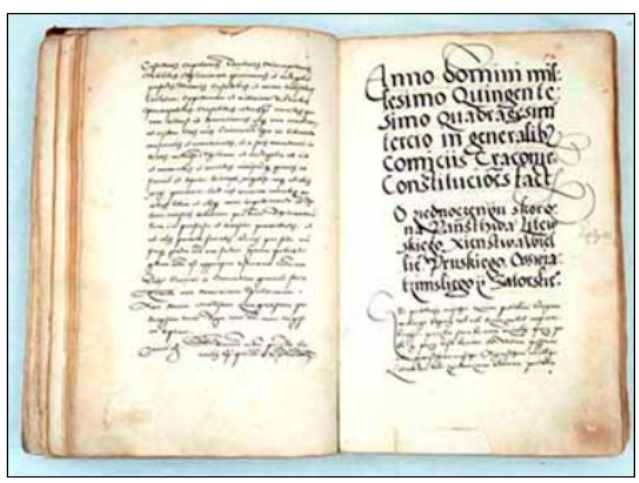
Figure 4. Example of a description of the manuscript (source: The Central Archive of Historical Records in Warsaw, formerly presented on www.poland.pl).